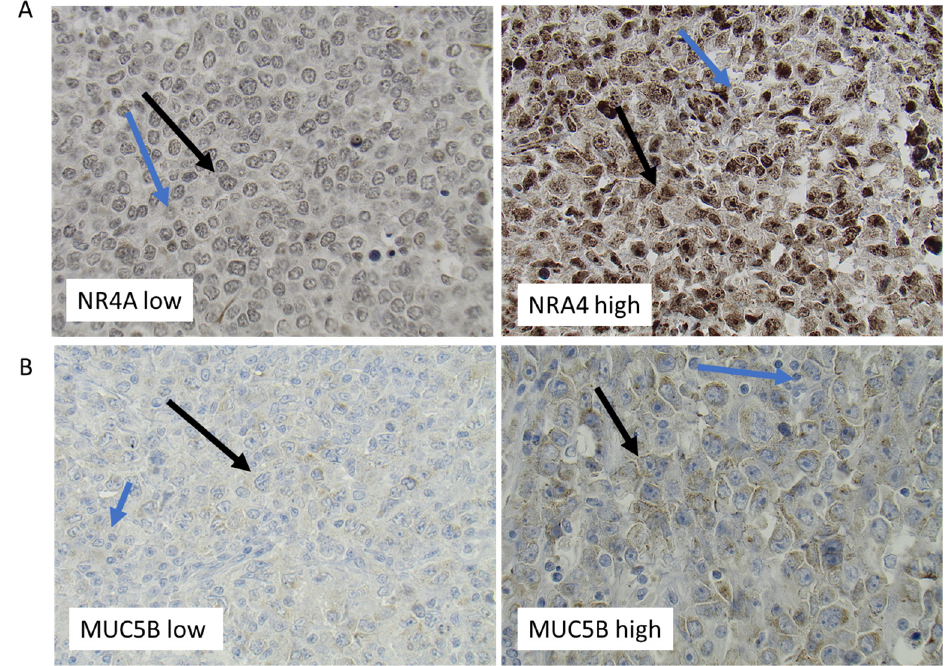
Figure 5. Representative immunohistochemistry staining of DLBCL lymphoma tissue for NR4A2 ( A ) and MUC5B ( B ). Immunohistochemical staining of DLBCL for NR4A2 ( A ) and MUC5B ( B ). Representative staining of samples with low ( left ) and high ( right ) expression, respectively. Black arrows mark examples of expression of NR4A2 and MUC5B in tumor cells, while blue arrows mark expression in non-malignant cells.